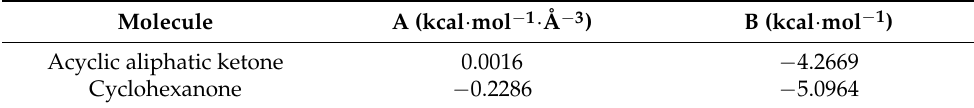
Table 3. Regression coefficients for correcting the GF-solvation free energy.